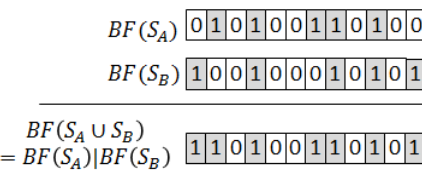
Figure 1. An example of two Bloom filter union, where the size of the Bloom filters, the number of hash indices, and the used hash functions are